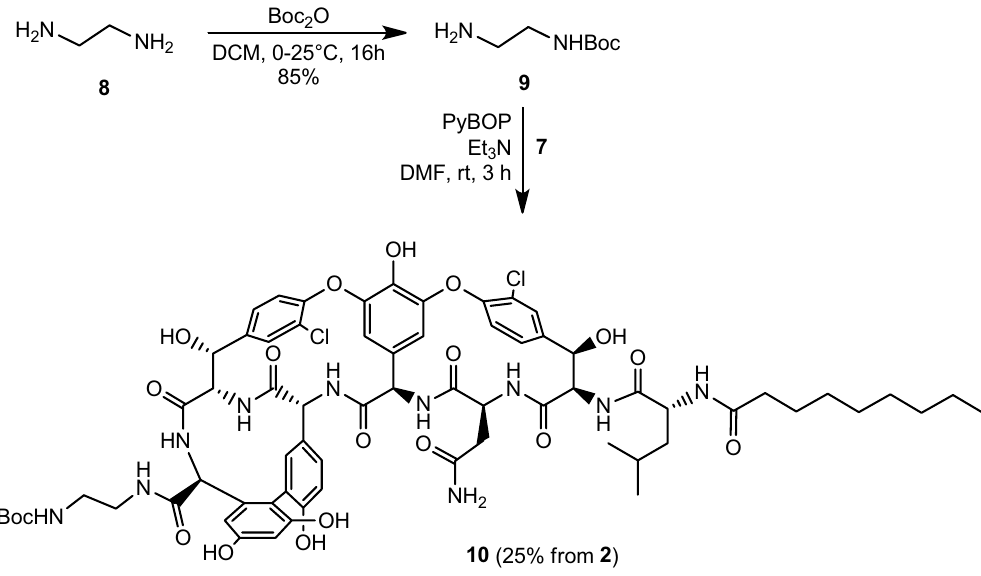
Figure 4. Amide formation at the C -terminal of vancomycin aglycone derivative 7